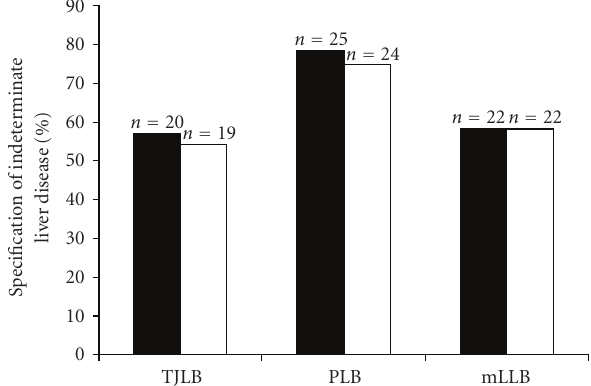
Figure 2: Indeterminate liver disease . Black bars show the percentage of cases in which the etiology of liver disease was identified during the clinical course. The white bars show the percentage of cases in which liver biopsy contributed substantially to the establishment of the diagnosis. No di ff erence was found between the rate of TJLB, PLB and mLLB.